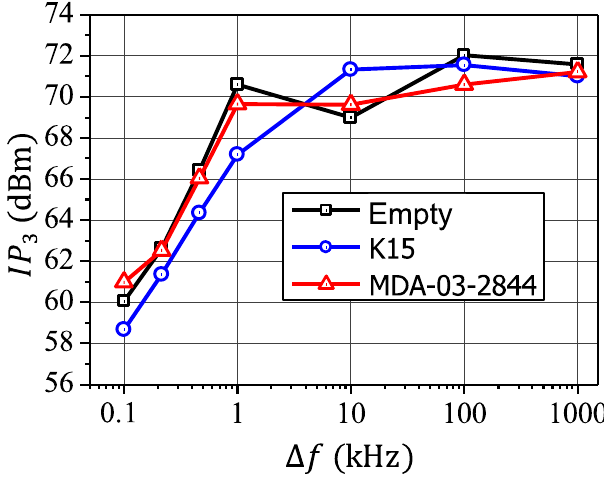
Figure 21. Measured IP 3 versus the frequency di ff erence ∆ f of the two tones at room temperature and maximum input power for three device configurations: empty (air) and filled with K15 and MDA-03-2844 [184–186].